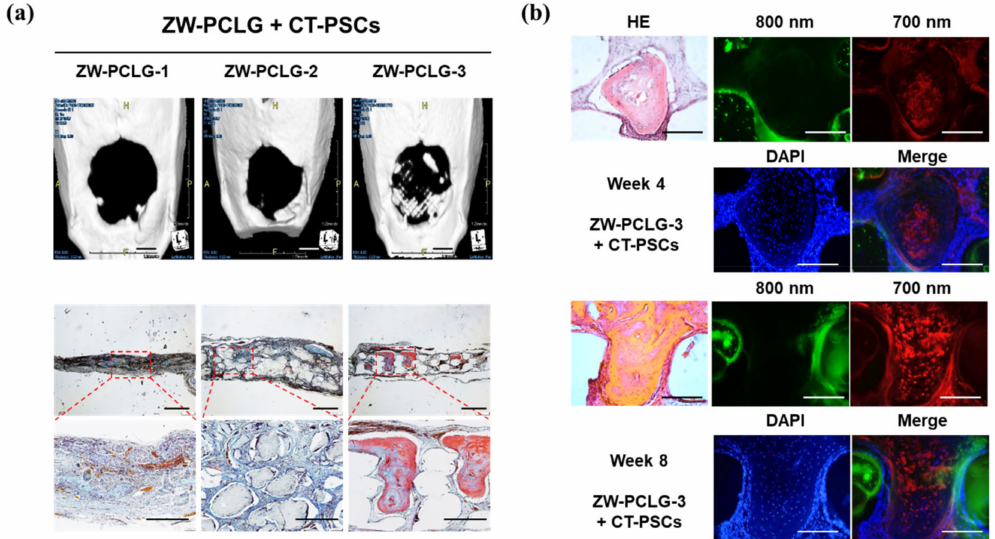
Figure 8. Computed tomography (CT) and histological examinations of the CT-PSCs and PCLG sca ff olds. ( a ) New bone formation in the calvarial bone defect was examined by (top) CT (scale bar = 2 mm) and (bottom) modified Tetrachrome staining (scale bar = 1 mm). ( b ) High-power images to confirm hPSCs within the bone matrix in ZW-PCLG-3 + CT-PSCs. Green pseudocolor at 800 nm indicates the remaining PCLG sca ff old, red pseudocolor at 700 nm indicates hPSCs, and the blue color indicates DAPI-stained nuclei. Scale bar = 500 µ m. Reproduced with permission from